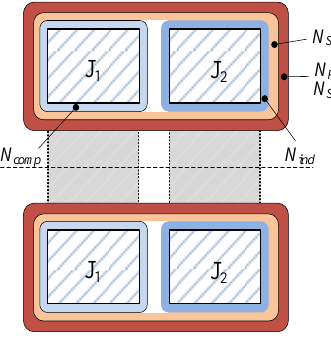
Figure 2. Cross-section view of cores with indicated windings.